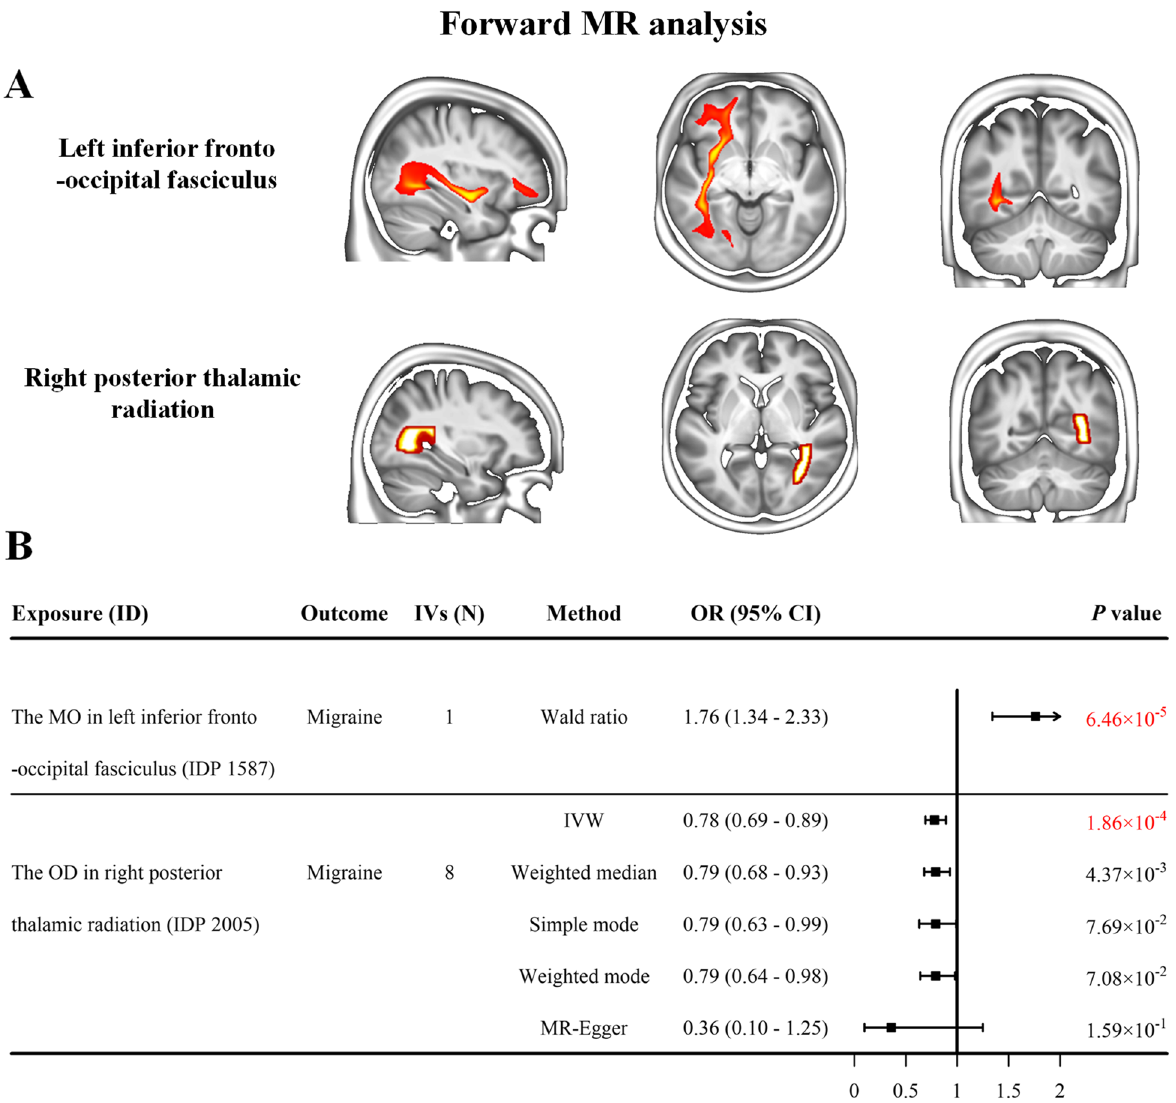
Fig. 2 The results of the forward MR analysis. A The anatomical locations of the WM IDPs showing significant causal associations with migraine in the forward MR analysis. B The forest plot shows the results of causal estimates. Each box represents the effect (i.e., OR change) per 1 SD change in the respective IDP on migraine, and the error bars represent 95% CI. Arrows indicate that 95% CI exceeds the x axis. Significant causal correlation is defined as p value < 3.29 10 − 4 (Bonferroni correction) and marked by red chroma. The IVW (if the number of IVs > 1) -derived or Wald ratio (if × the number of IVs 1) -derived results were regarded as main results. Abbreviations: CI, confidence interval; IDP, imaging-derived phenotypes; IVs, = instrumental variables; IVW, inverse variance-weighted; MR, Mendelian randomization; OR, odds